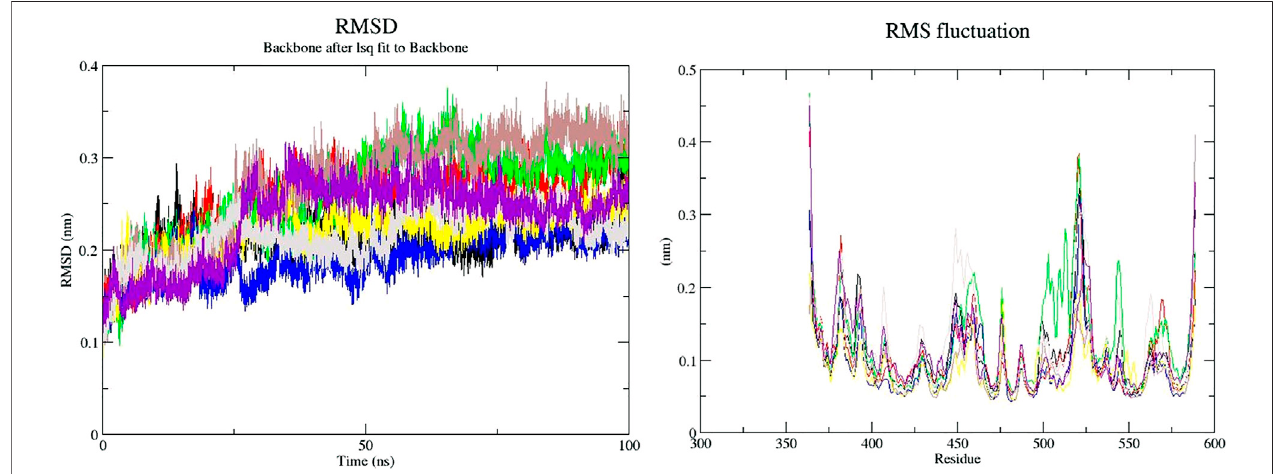
FIGURE 1 | RMSD and RMSF plots of free-SENP2 and SENP2 complexes (black) free-SENP2, red) GA, green) CA, blue) TQ, yellow) Betanin, brown) Betanidin, gray) Ebselen, and purpule) Fisetin).